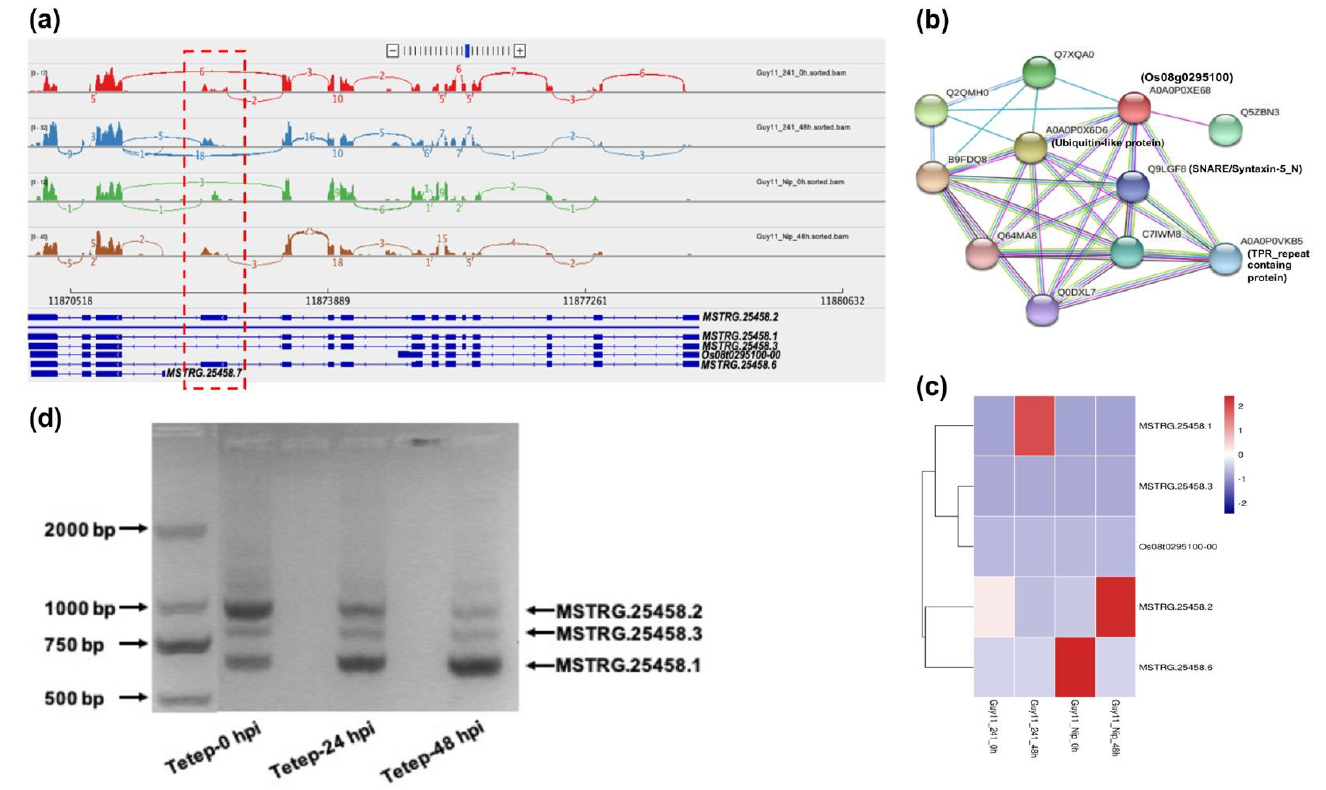
Figure 4. Sashimi plots and protein–protein network (PPI) analysis for Os08g0295100. ( a ) Sashimi diagram showing the exon-intron structure of representative annotated transcripts and novel isoforms. The red dashed box encloses the location of the AS events. ( b ) The PPI network for the protein produced by Os08g0295100 . Green, red, and blue lines indicate interactions predicted from gene neighborhood, fusions, and co-occurrence. Light green, black, and dark blue lines indicate additional interactions inferred from text mining, co-expression, and protein homology. ( c ) Expression profile of an annotated transcript and novel isoforms produced by Os08g0295100 . ( d ) PCR amplification of transcripts/isoforms generated by Os08g0295100 at 0, 24, and 48 hpi.